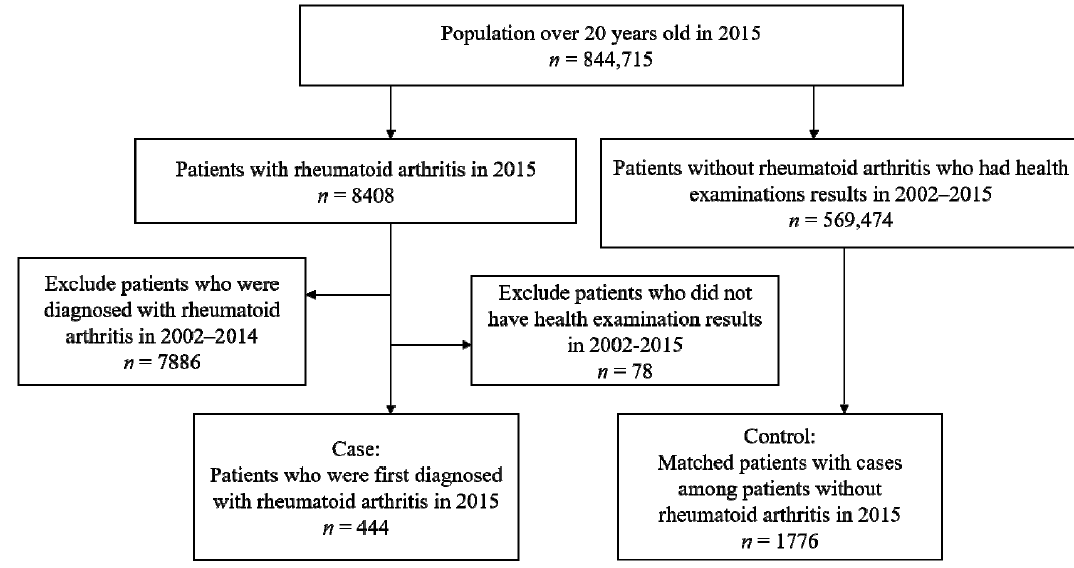
Figure 1. Flow chart of the study population.